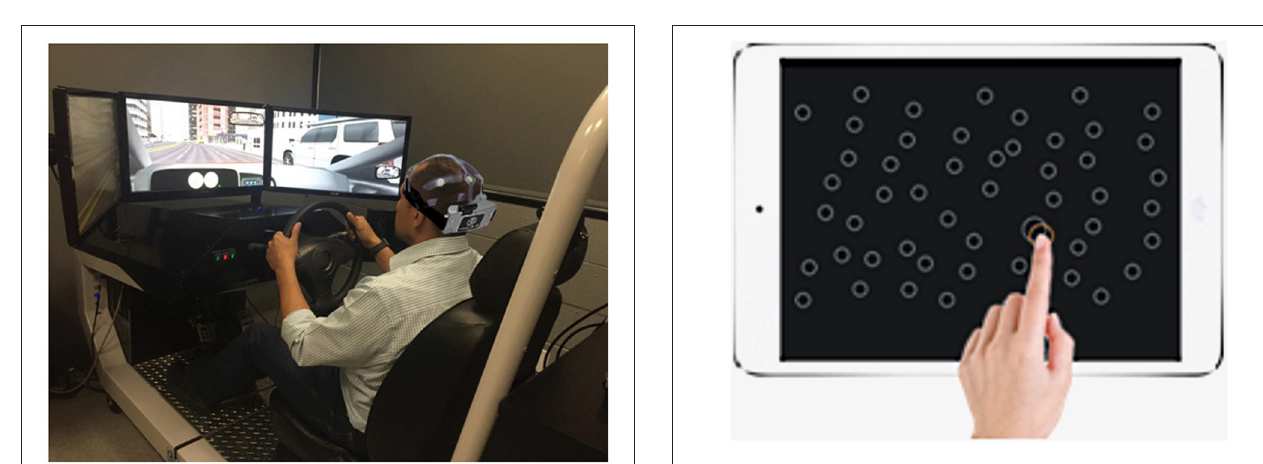
FIGURE 1 | STISIM M300WS console with participant (written informed consent obtained).